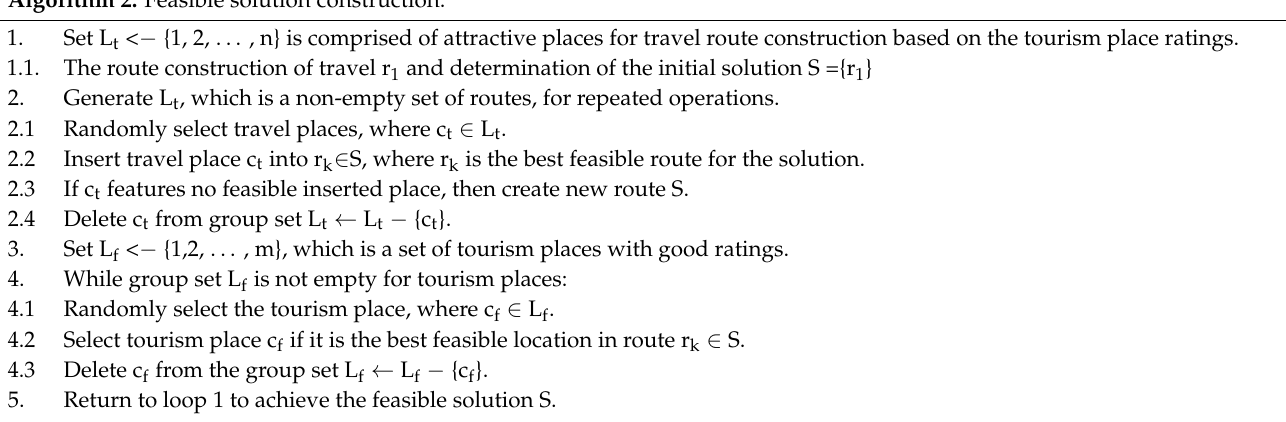
Algorithm 2. Feasible solution